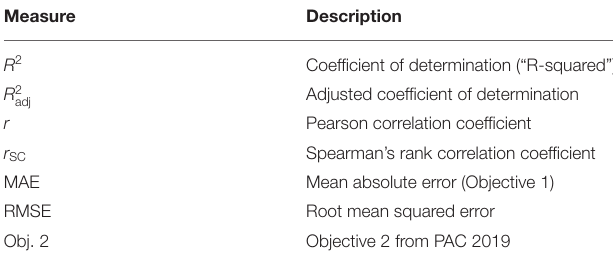
TABLE 3 | Measures of prediction